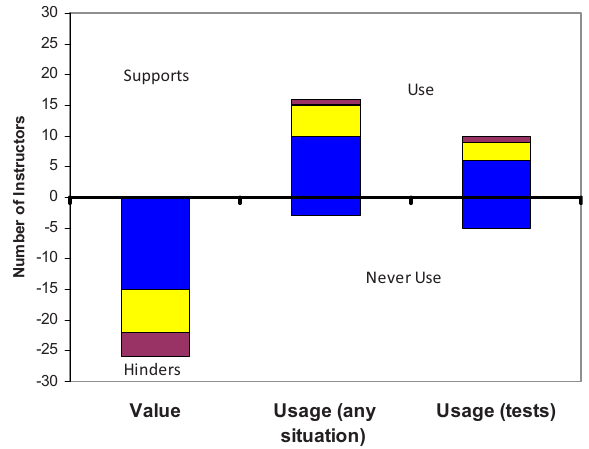
FIG. 10. (cid:1) Color (cid:2) Value and usage of problem features related to the teaching goal of not leading students through problems. The legend is in